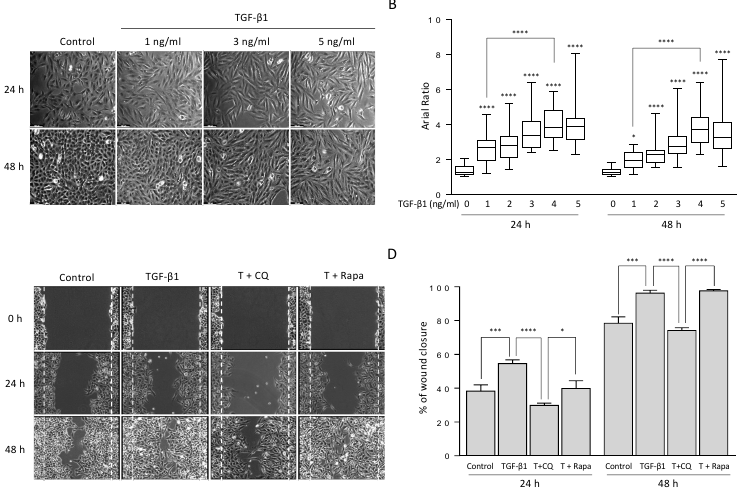
Figure 1. TGF- β 1 changed cell morphology from epithelial to mesenchymal-like cells and increased cell migration ability. ( A ) Morphological changes of A549 cells under TGF- β 1 treatment. A549 lung